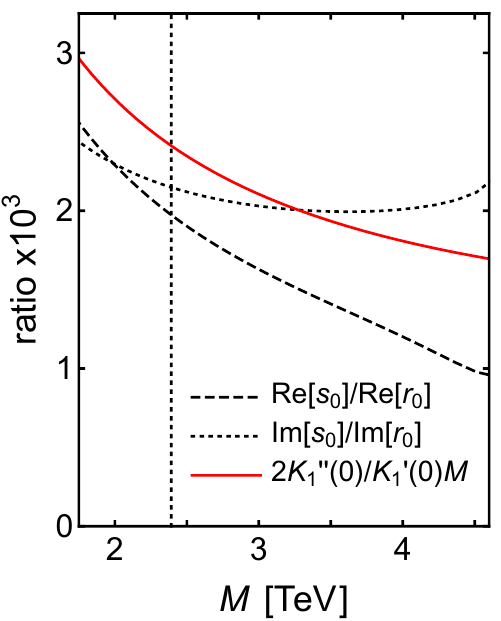
Figure 21 . The ratio of the real parts of s 0 and r 0 (dashed curve) and the ratio of the imaginary parts of s 0 and r 0 (dotted curve) as functions of the wino mass M . The solid line is the parameter- free prediction of ZREFT at LO in eq. (5.24). The vertical dotted line indicates the unitarity mass M (cid:3) = 2 : 39